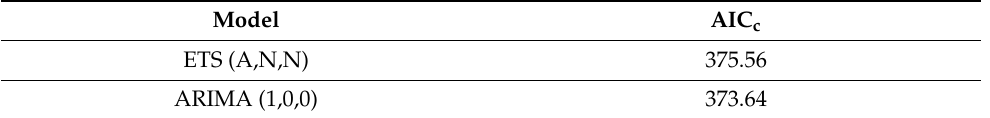
Table 3. Corrected Akaike Information Criterion (AIC c ) for Time Series Prediction Models.